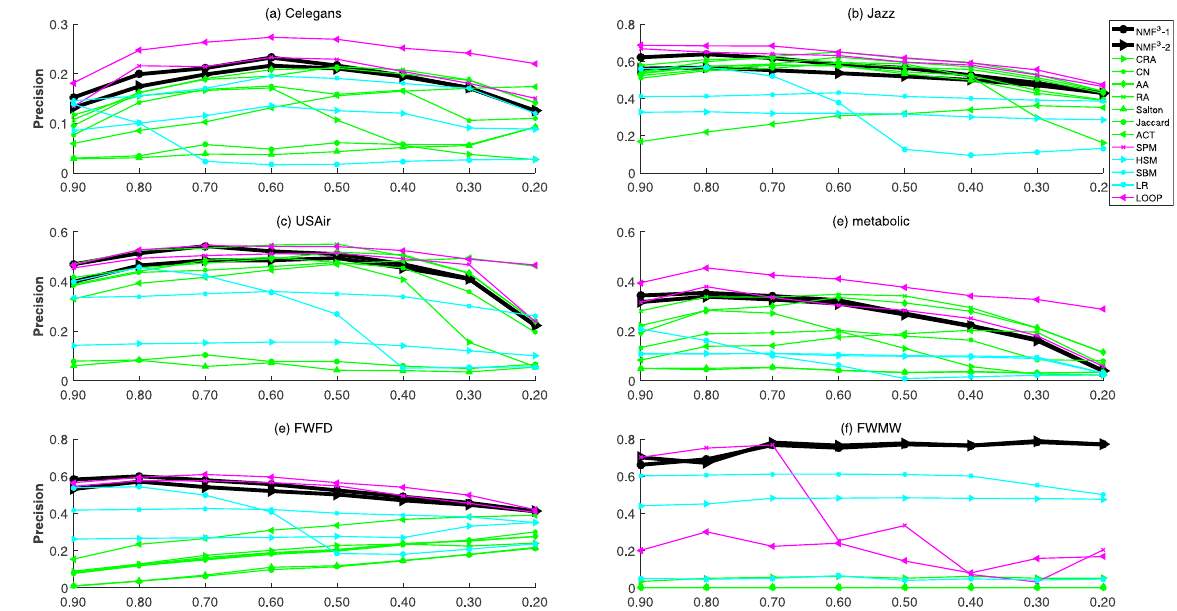
Figure 3. The comparison of precision of six networks under different fractions of missing links. Besides our kernel framework ( NMF 3 − 1, NMF 3 − 2), we further compare our methods with eight well-known methods (AA, RA, CN, Salton, ACT, Jaccard, CRA, SPM, HSM, SBM, LP, LOOP). Each data point is averaged over 100 independent